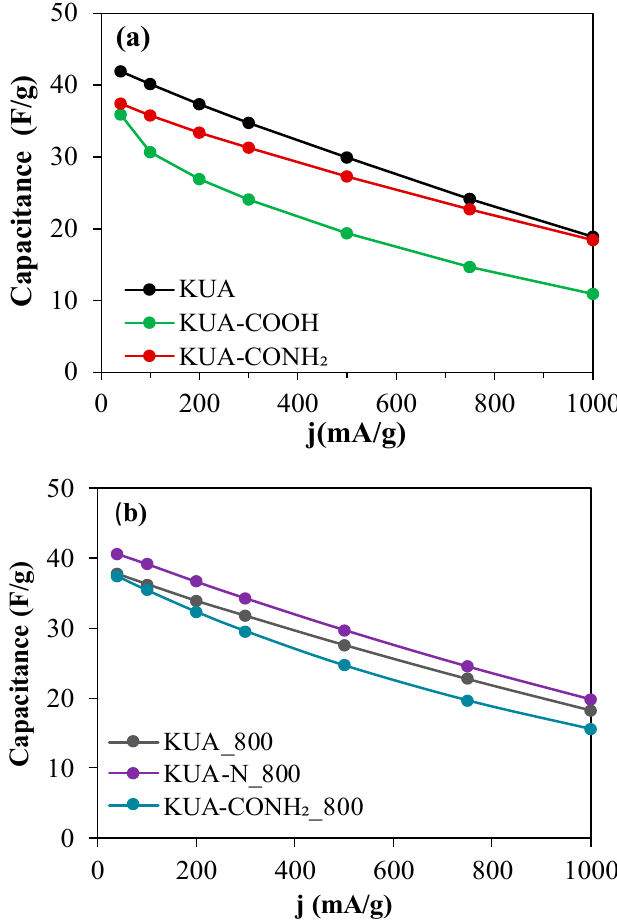
Figure 6. Rate performance (dependence of gravimetric capacitance on current densities) for selected EDLCs: ( a ) KUA, KUA-COOH and KUA-CONH 2 ; ( b ) KUA_800, KUA-N_800 and KUA-CONH 2 _800.